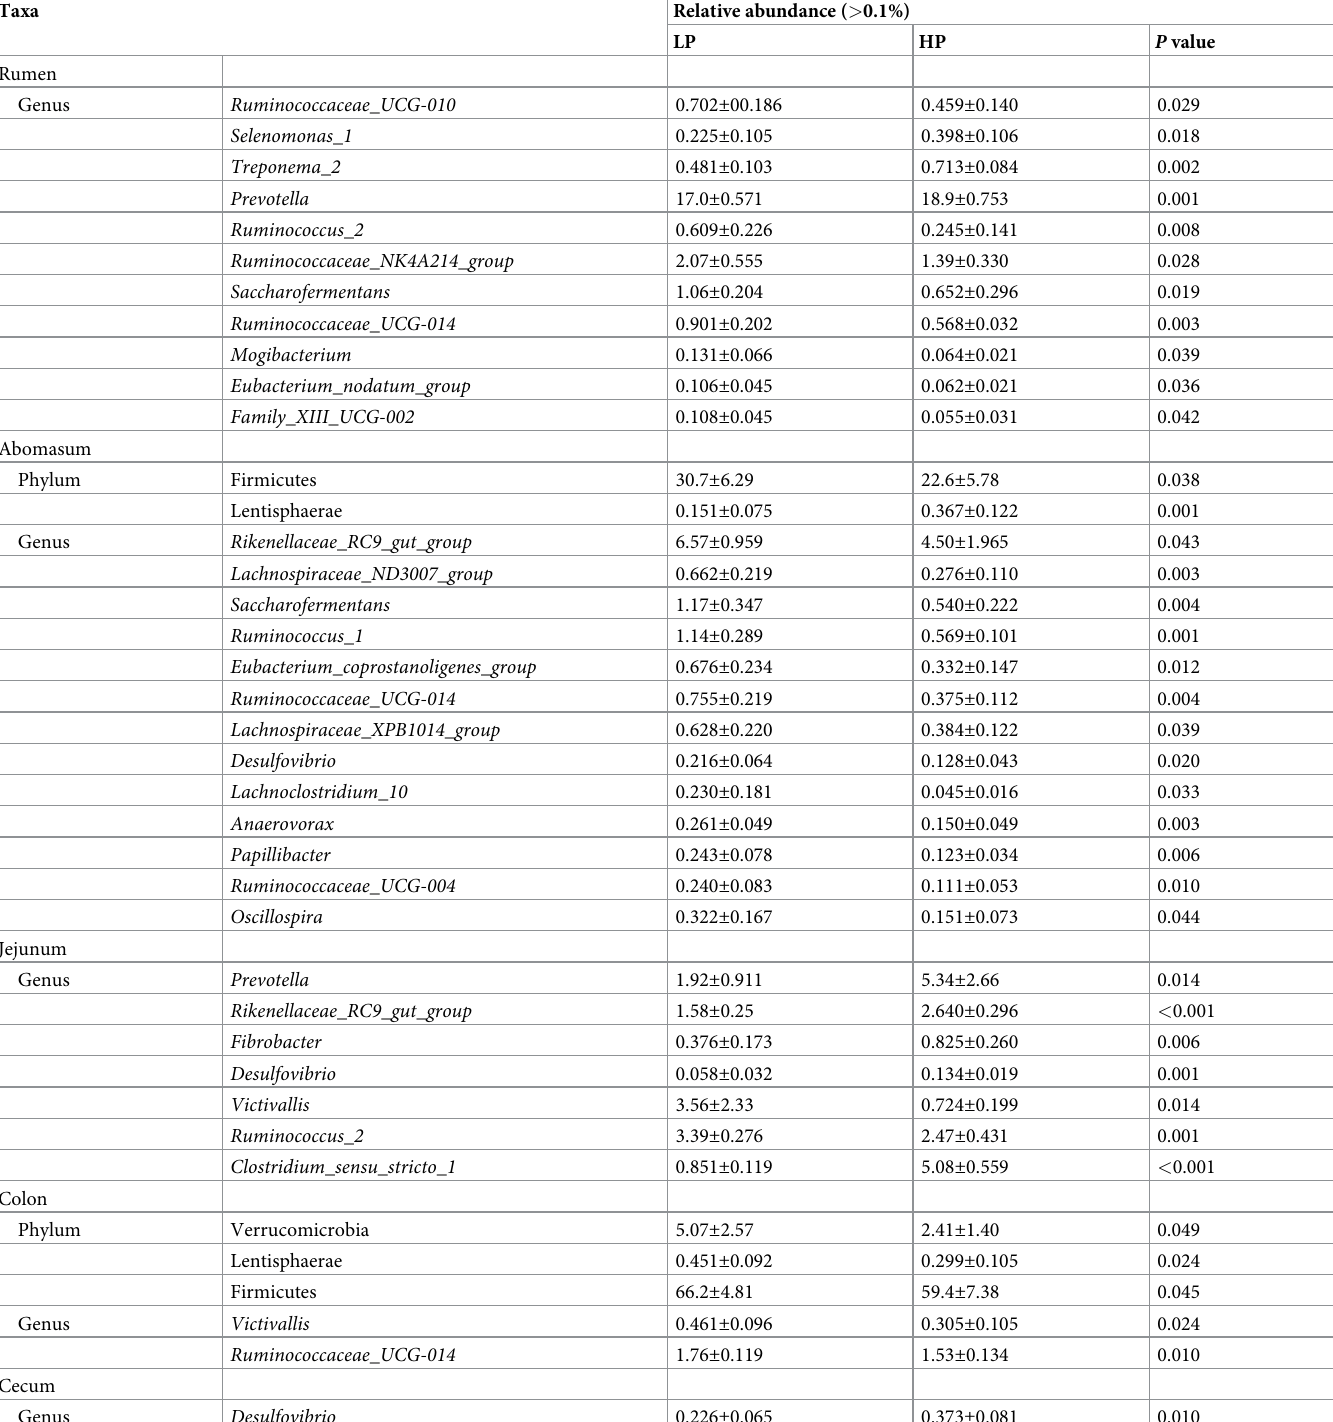
Table 5. The bacterial phyla and genera whose relative abundances were significantly different between HP and LP across the GIT.